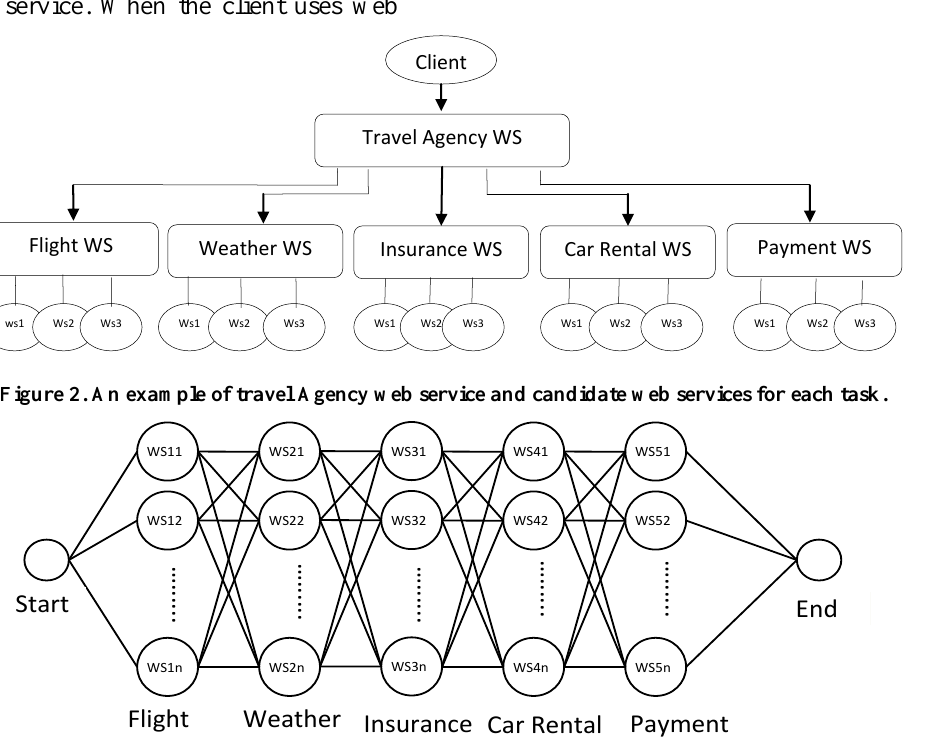
Figure 3. All composition plans for travel agency